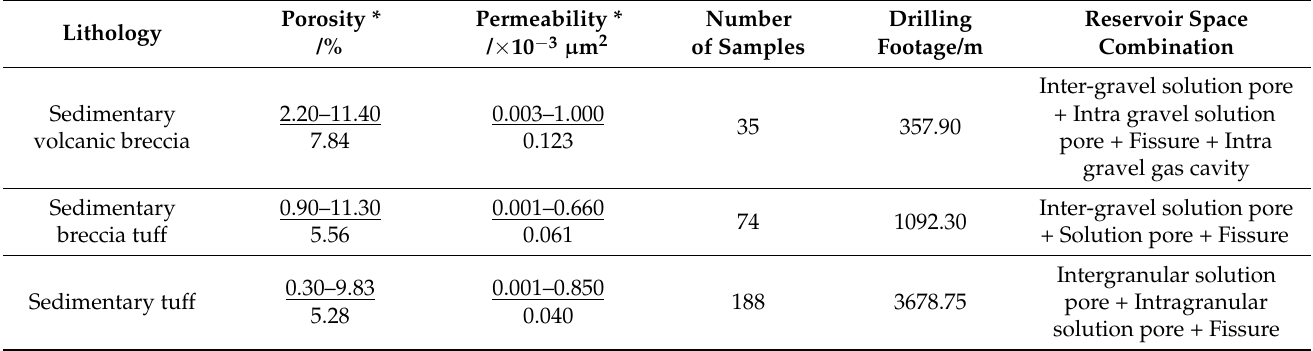
Table 1. Reservoir characteristics of sedimentary pyroclastic rocks in K 1 y 2 ,